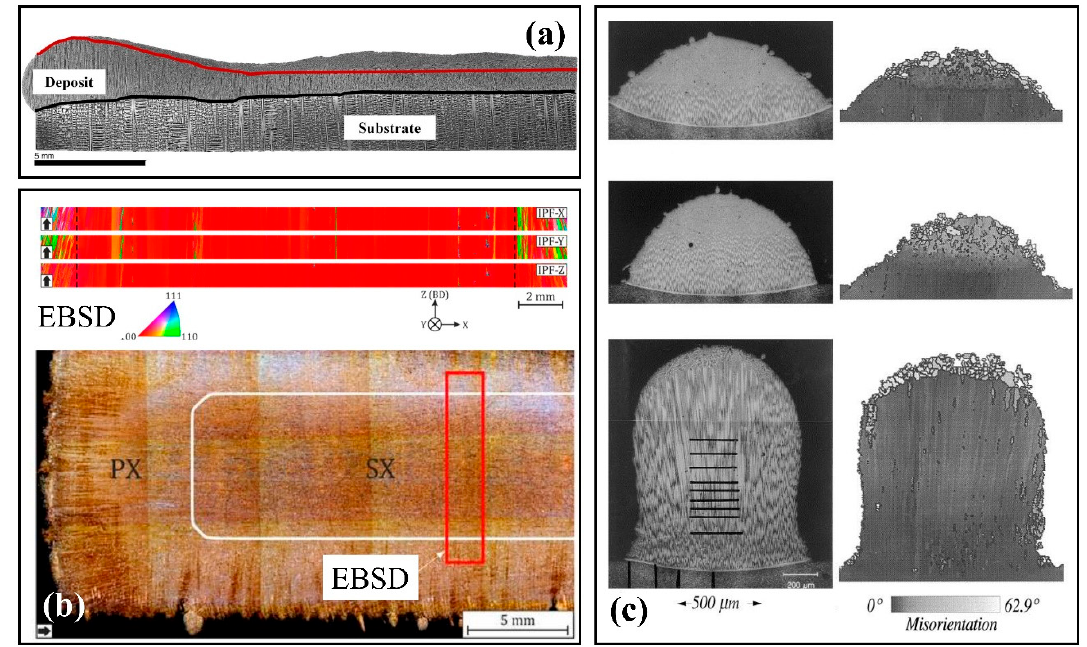
Figure 11. Representative optical images showing the capability of different AM processes in repairing a candidate SX alloy, CMSX-4 ® —( a ) laser powder bed fusion (PBF) (L-PBF) (Reproduced with permission from [100]), ( b ) E-PBF (Reproduced from [101] under the terms of the Creative Commons Attribution 4.0 License from http://creativecommons.org/licenses/by/4.0/), and ( c ) laser- based DED (L-DED) (Reproduced with permission from [102]). Electron backscatter diffraction (EBSD) refers to electron backscatter diffraction.